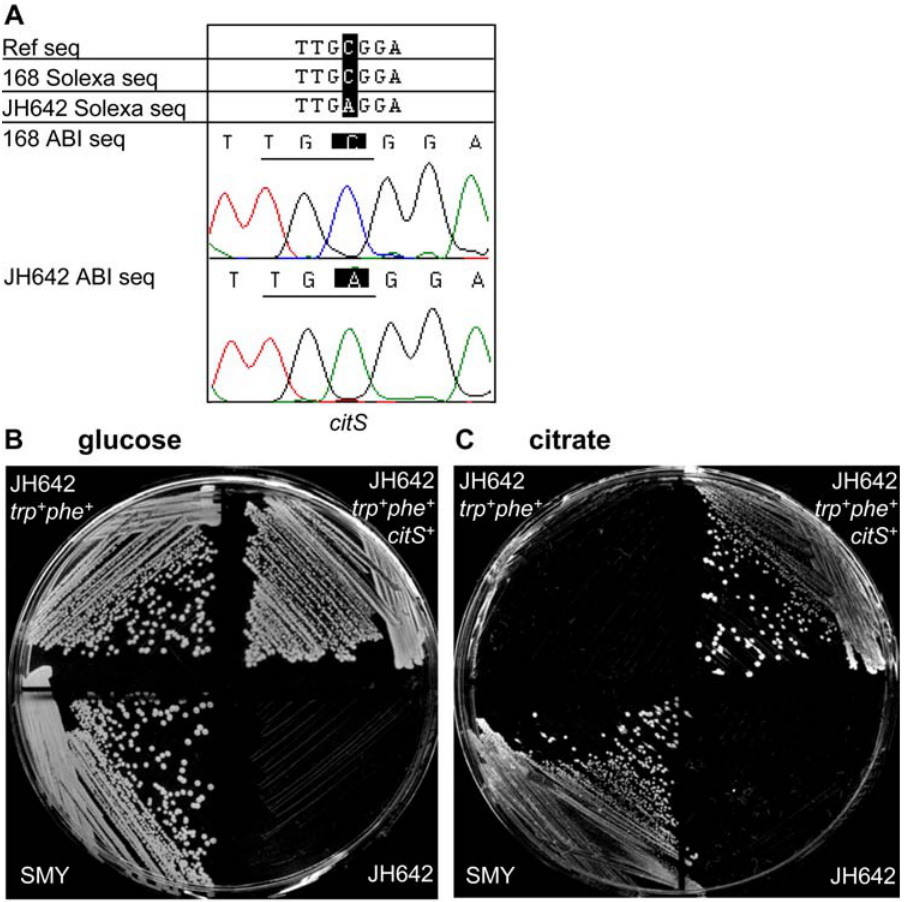
Figure 4. Verification that the nonsense mutation in citS leads to a defect in the citrate import pathway. A) Sanger sequencing verification of the Solexa citS sequence. Sequences are shown in the following order: the published reference sequence first, followed by the Solexa results for the citS gene in strains 168 and JH642, and the Sanger results for both strains shown last. B, C) Rescue of the citS- phenotype of JH642. Strains were plated to obtain single colonies on minimal media supplemented with glucose (B) or citrate (C) as the sole carbon source. The strains shown are: the prototroph SMY, the lab strain JH642, a JH642-derived strain that is ‘cured’ of its growth-dependence on the amino acids tryptophan and phenylalanine (JH642 trp + , phe + ), and finally, the latter strain, transformed with the complete citS gene from SMY (JH642 trp + phe + citS + ). JH642 trp + phe + is able to utilize glucose but not citrate. JH642 trp + phe + citS + is able to utilize both glucose and citrate.